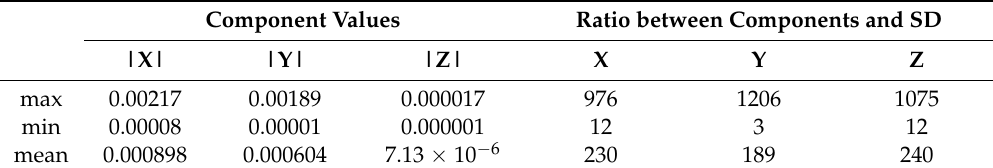
Table 4. Left column: summary statistics of the component values of the orthogonal projection of the vector ε onto the general plane and of the ratio between the components and their SD (right column). Component Values Ratio between Components and SD